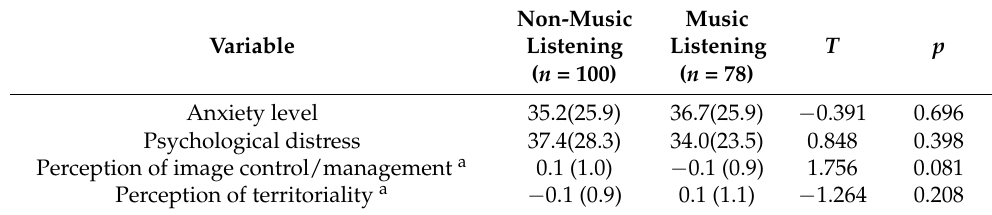
Table 7. Differences in psychological states and perceptions between the two participant